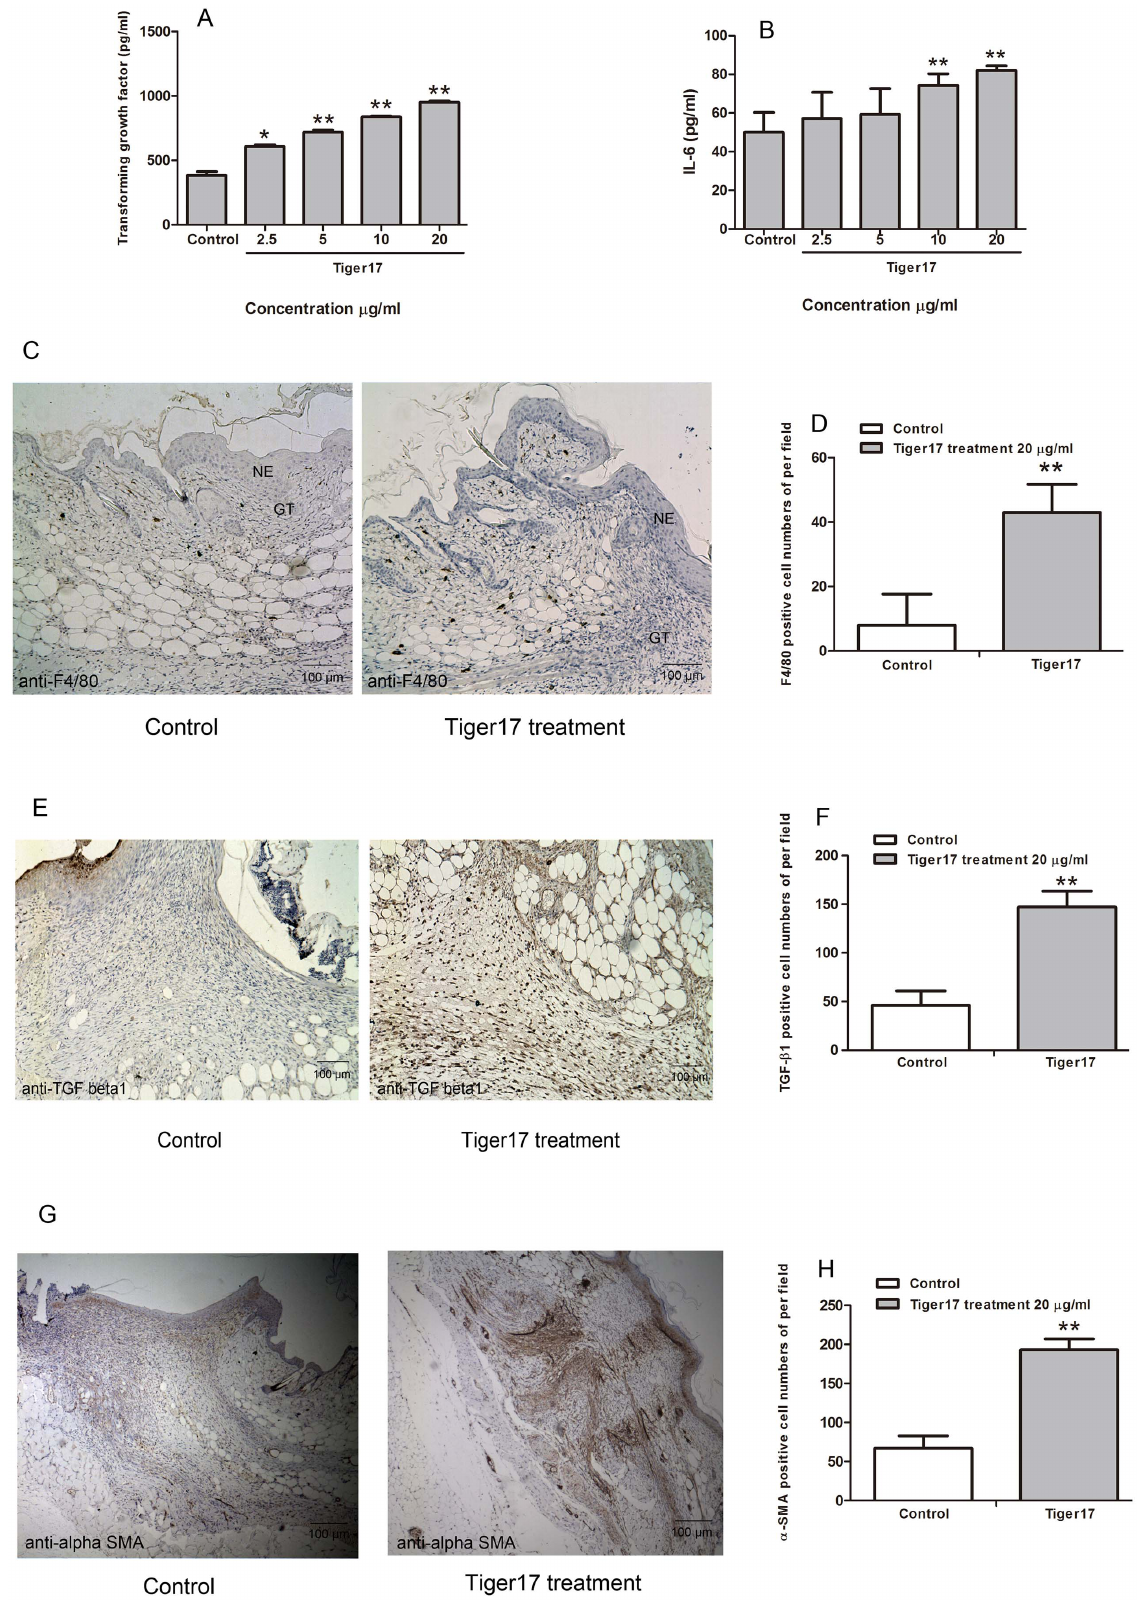
Figure 3. Tiger17 promoted macrophages recruitment, TGF- b 1 upexpression and myofibroblasts differentiation. (A, B) Concentration of TGF- b 1 or IL-6 (pg/ml) in the control and various concentration tiger17 (2.5, 5, 10, 20 m g/ml)-treated supernatant. Values are expressed as mean 6